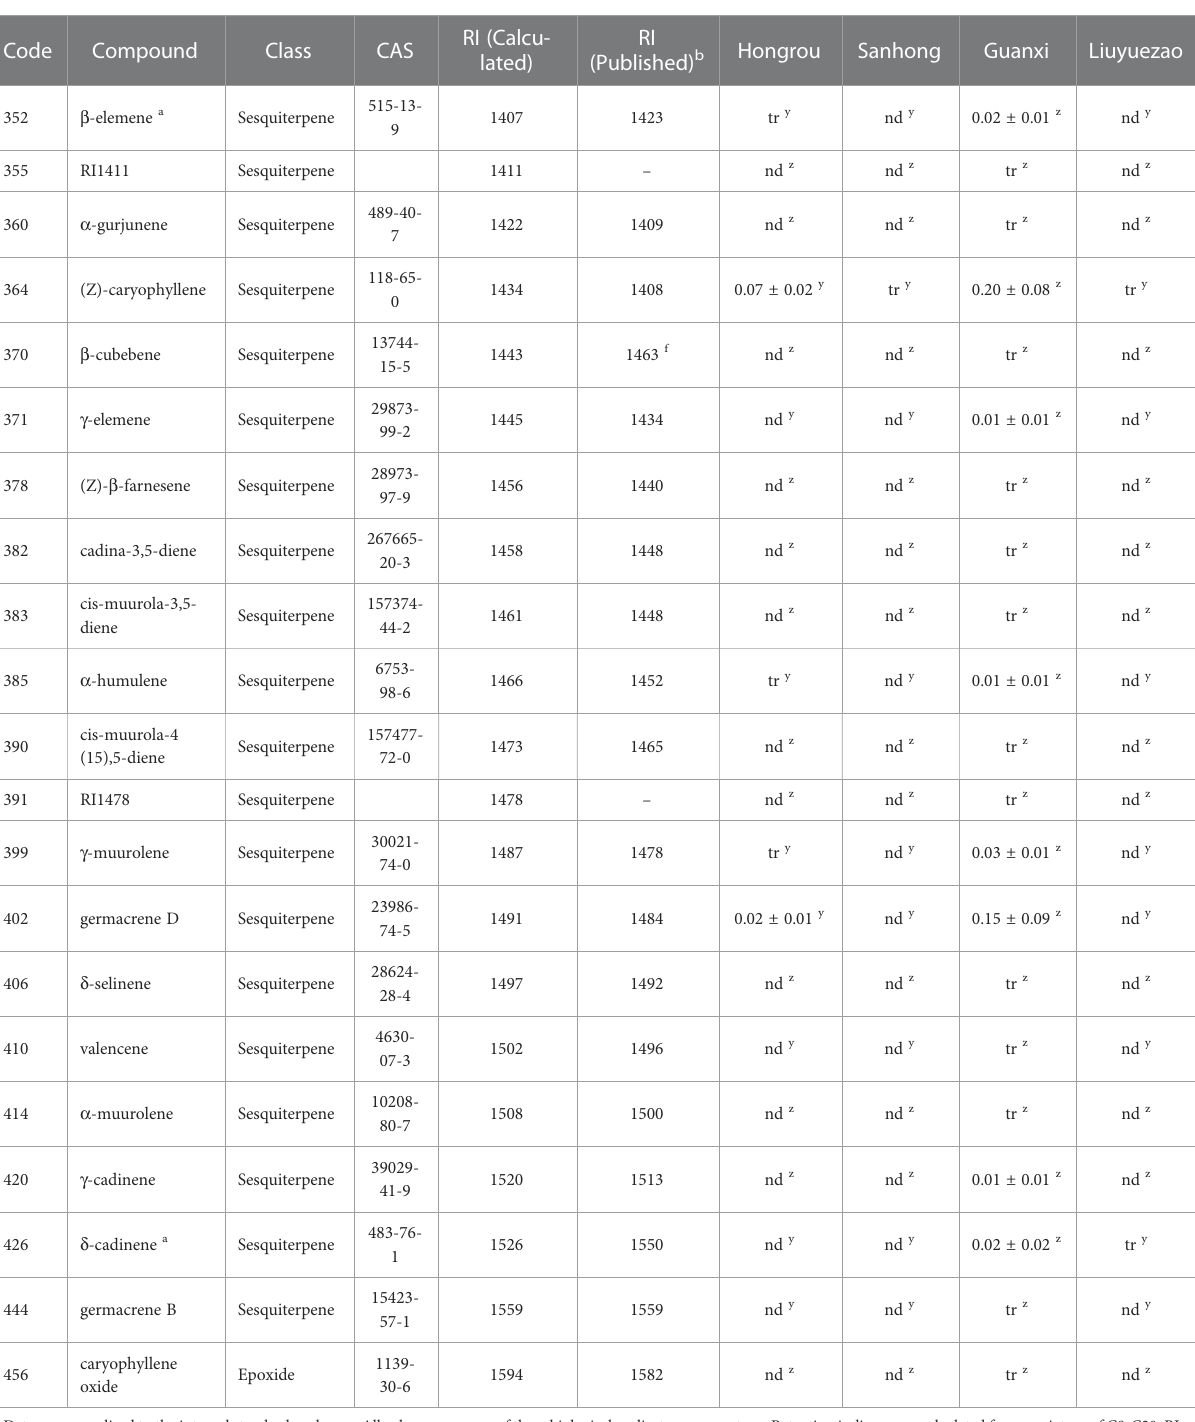
Dataarenormalizedtotheinternalstandardpeakarea.Allvaluesaremeansofthreebiologicalreplicatespergenotype.Retentionindices werecalculated fromamixtureofC8-C20.RI: retention index; tr: peak was detected but the value less than 0.0095; nd: not detected. a Identi fi ed by authentic volatile compound standards. b Published retention indices on DB-5 column reported by (Adams, 2007) unless mentioned otherwise. c Published retention indices on DB-5 column reported on PubChem (Kim et al., 2021). d Published retention indices on DB-5 column reported on NIST Chemistry WebBook (Linstrom and Mallard, 2022). e Published retention indices on DB-5 column reported on Flavornet and Human Odor Space (Acree and Arn, 2004). f Published retention indices on DB-5 column reported by (Miyazaki et al., 2011). z-x Different letters in the same rows indicate signi fi cant differences according to Tukey ’ s honestly signi fi cant difference test at P <